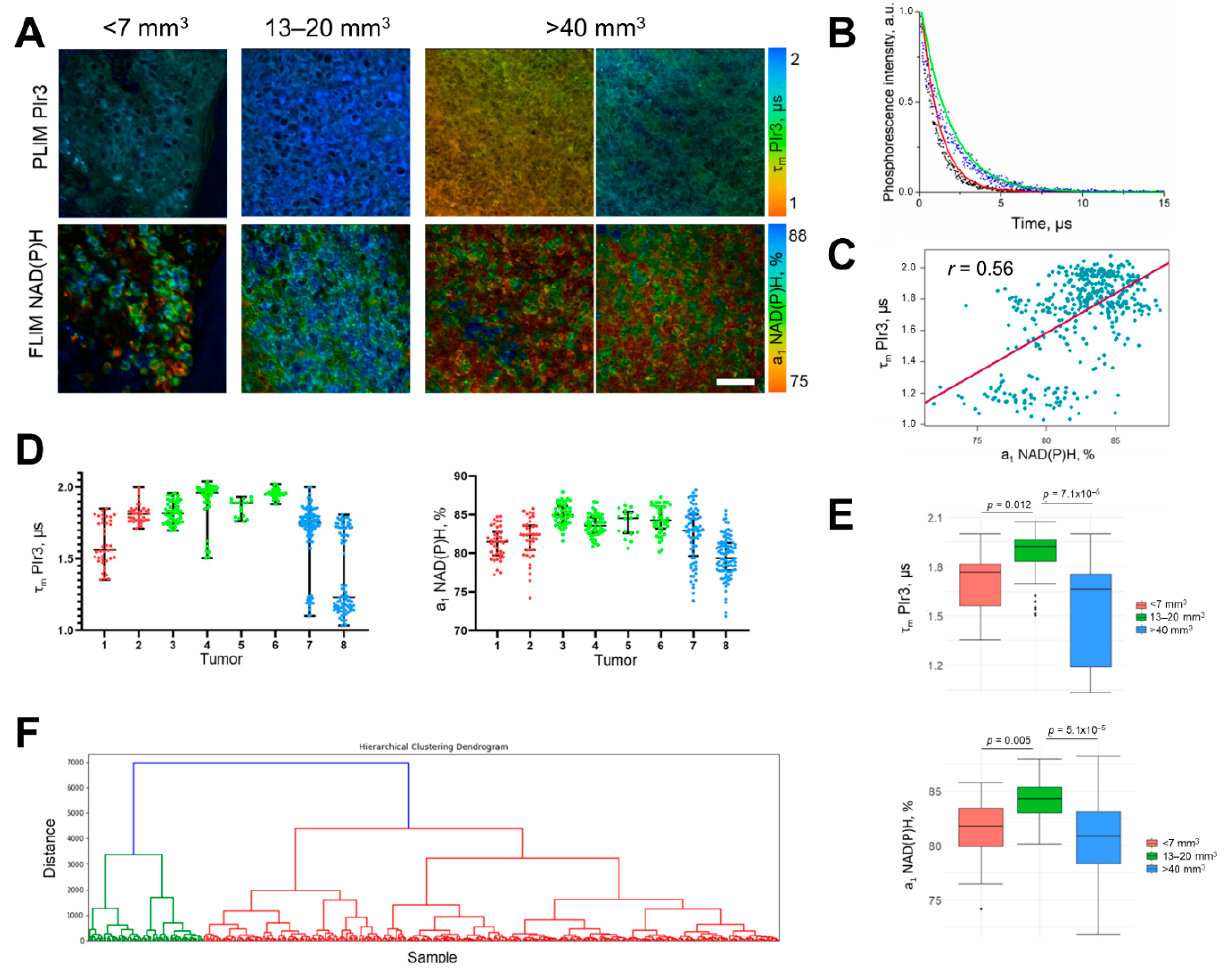
Figure 9. Simultaneous oxygen PLIM and metabolic FLIM of CT26 tumors in vivo. ( A ) PLIM and FLIM images of tumors of different sizes. Tumor volume is indicated above the images. Scale bar = 50 µ m. For FLIM: ex. 750 nm, reg. 450–490 nm. For PLIM: ex. 750 nm, reg. 570–640 nm. ( B ) Phosphorescence decay curves of the polymer probe PIr3 in the zones of normoxia (red line) and hypoxia (green line). Black or blue dots are the experimental data. ( C ) Scatter plot for cell measurements of PIr3 phosphorescence lifetime ( τ PIr3) and NAD(P)H fluorescence lifetime (a 1 , %). The Pearson correlation r is shown. ( D ) Phosphorescence lifetime of the PIr3 polymer probe and the relative contribution of free NAD(P)H (a 1 , %) in the individual tumors numbered from 1 to 8. The median and the quartiles Q1 and Q3 are shown. Dots are the measurements in the cytoplasm of individual cells. ( E ) Comparisons of τ PIr3 and a 1 NAD(P)H between tumors of different volumes. Box shows the median and the quartiles Q1 and Q3, whiskers show minimum and maximum. n = 8–10 fields of view from 2–4 tumors. ( F ) Dendrogram of hierarchical clustering showing the presence of two clusters in a cell population corresponding to the normoxic (green) and hypoxic (red)